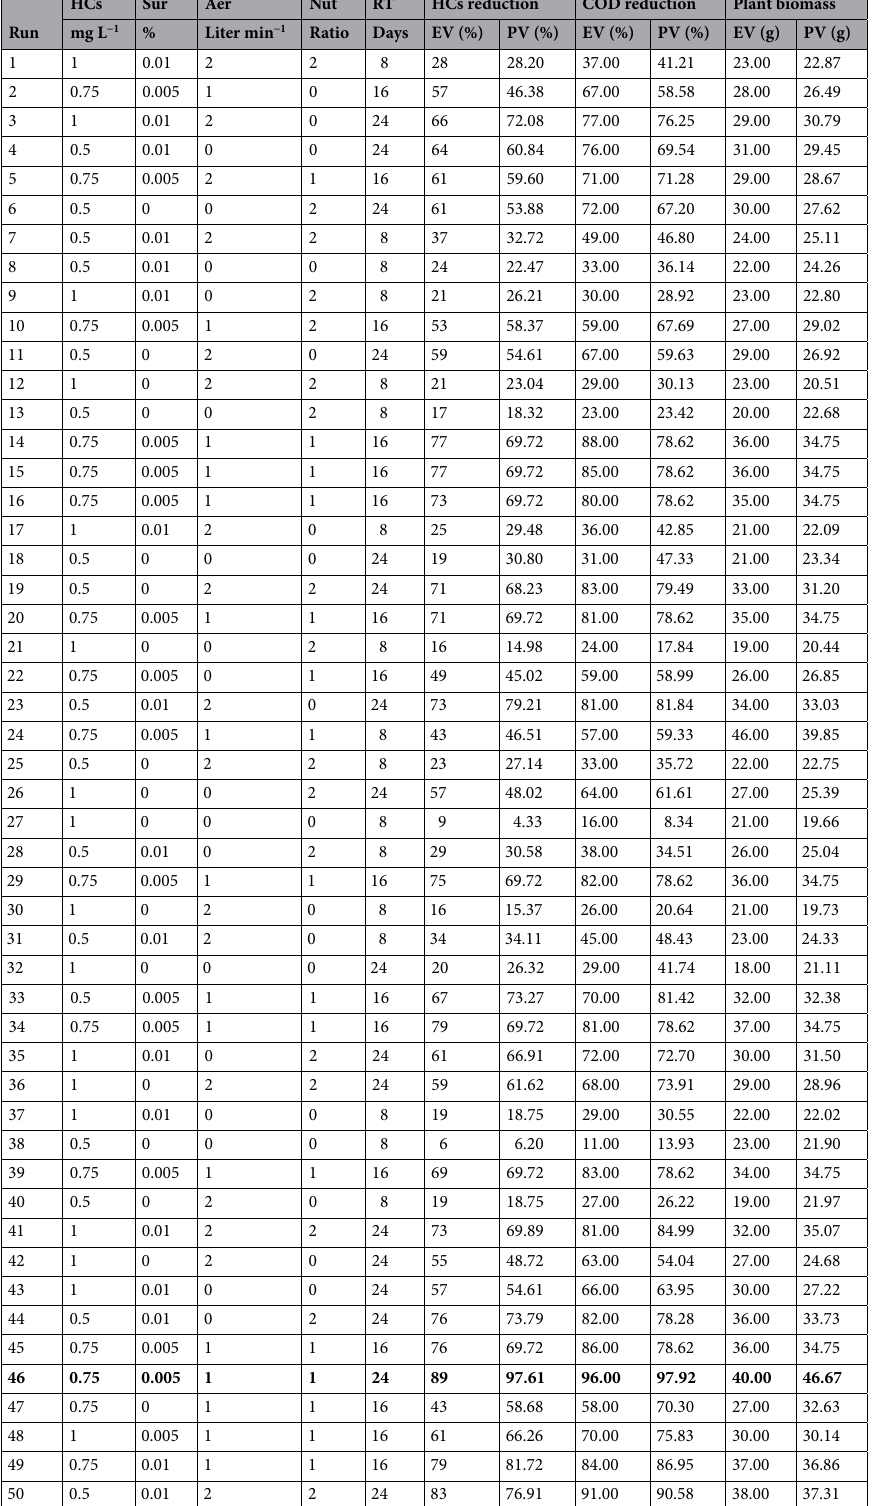
Table 2. Central composite design matrix for the five independent variables with the observed and predicted response for oil removal, COD reduction and plant biomass. EV experimental value, PV predicted